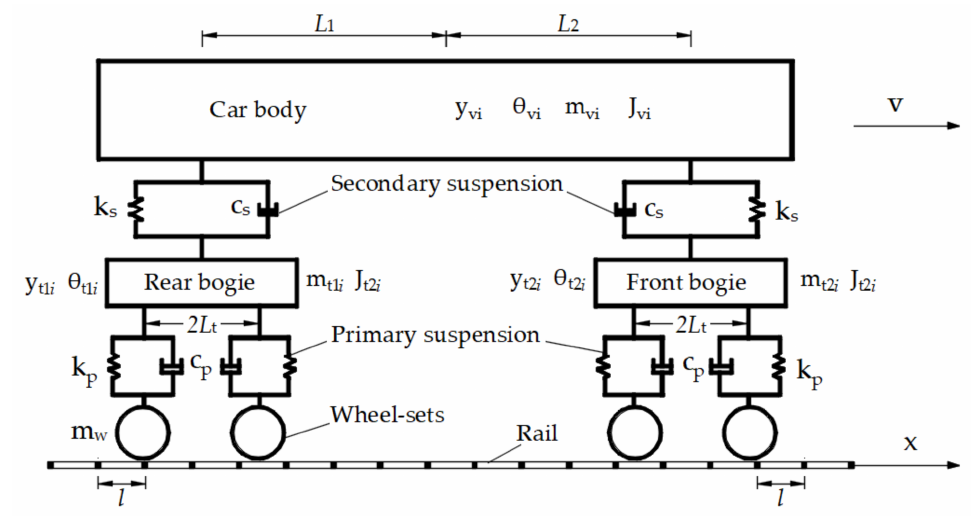
Figure 1. The mechanical model diagram of the high-speed train submodel.